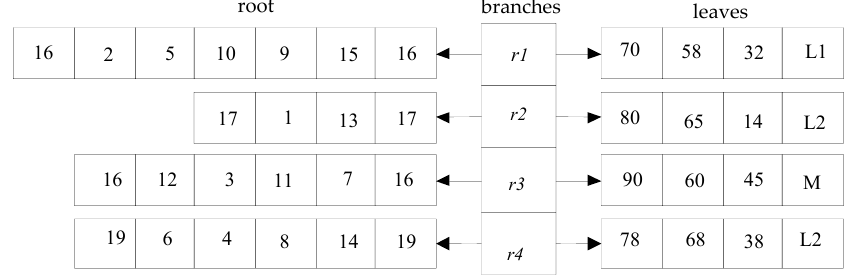
Figure 3. Illustration of chromosome representation.